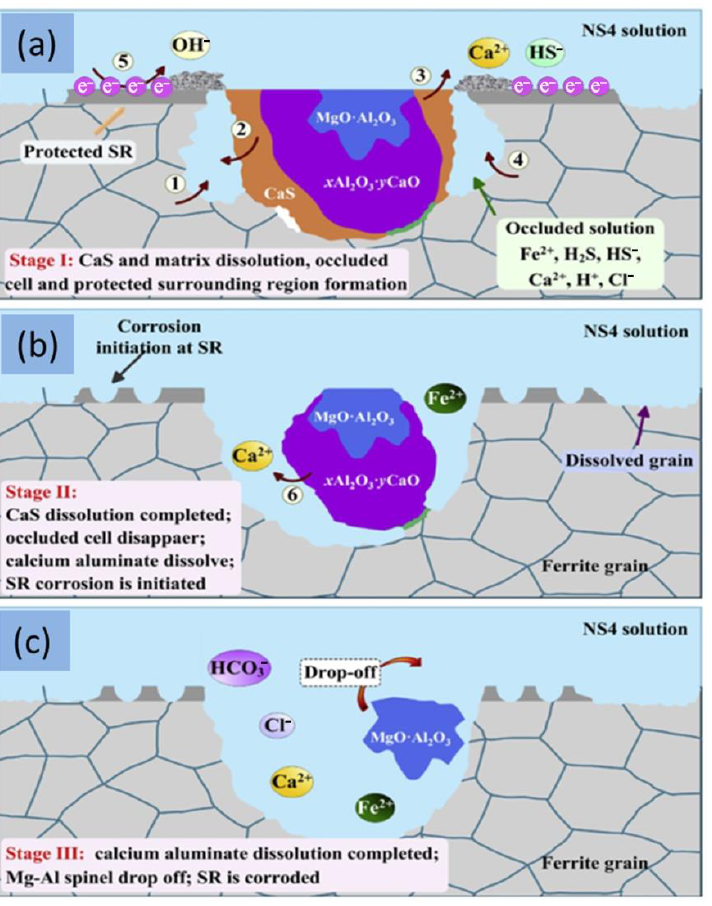
Figure 8. Schematic diagram of pit initiation and expansion process around Ds − type inclusions. ( a ) at stage I, ( b ) at stage II, ( c ) at stage III [11]. Reproduced with permission of Elsevier, copyright